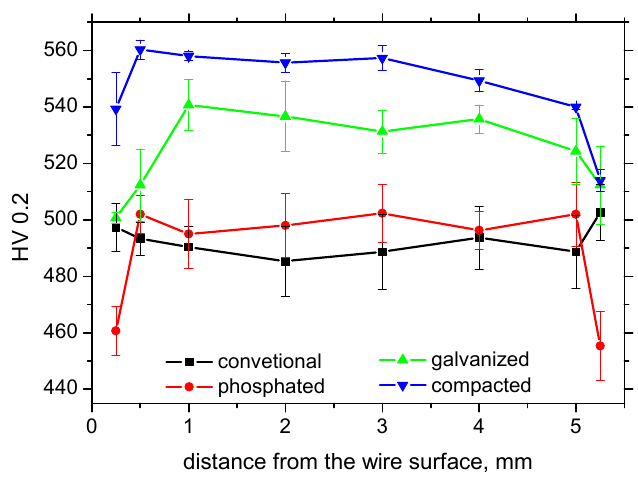
Figure 2. Evolution of microhardness HV0.2 across the wire diameter.